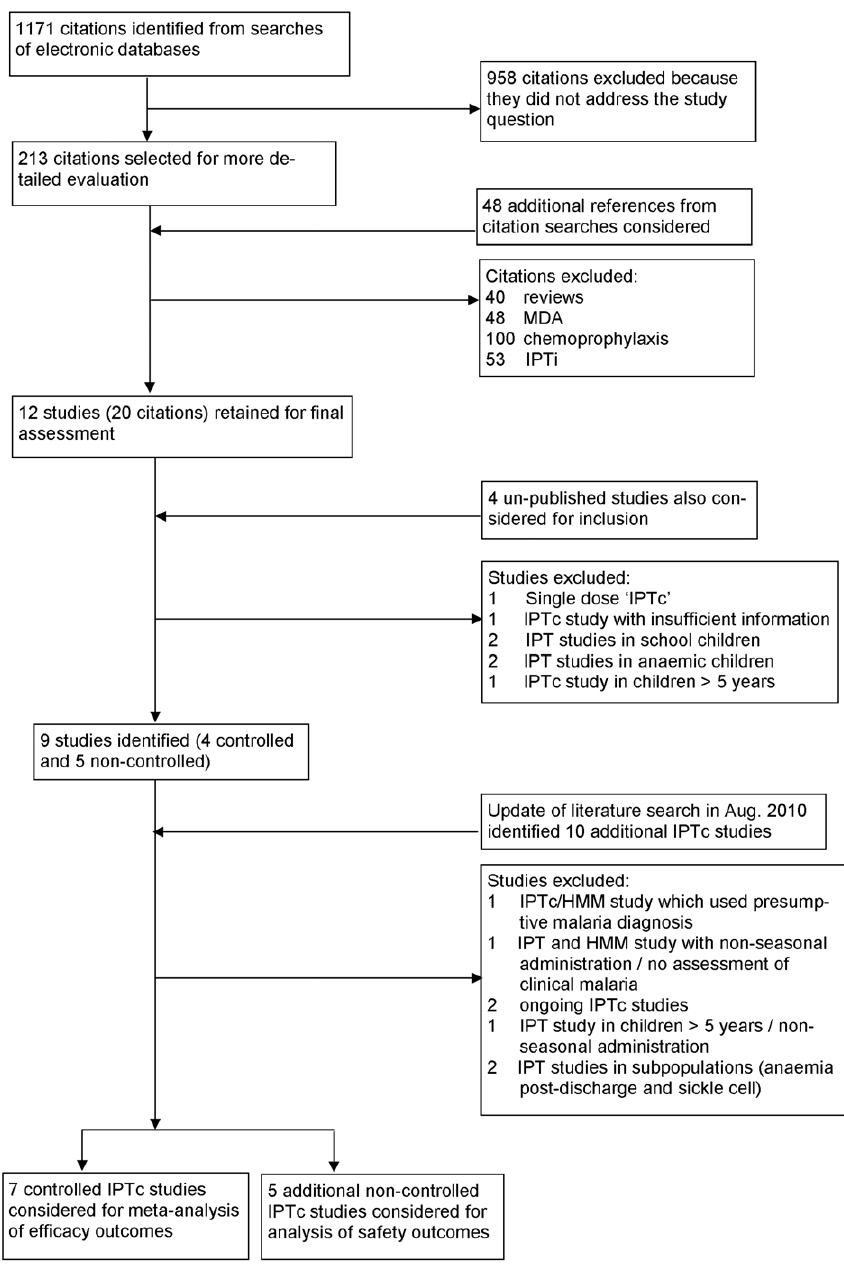
Figure 1. Flow Diagram of Study Selection Process.